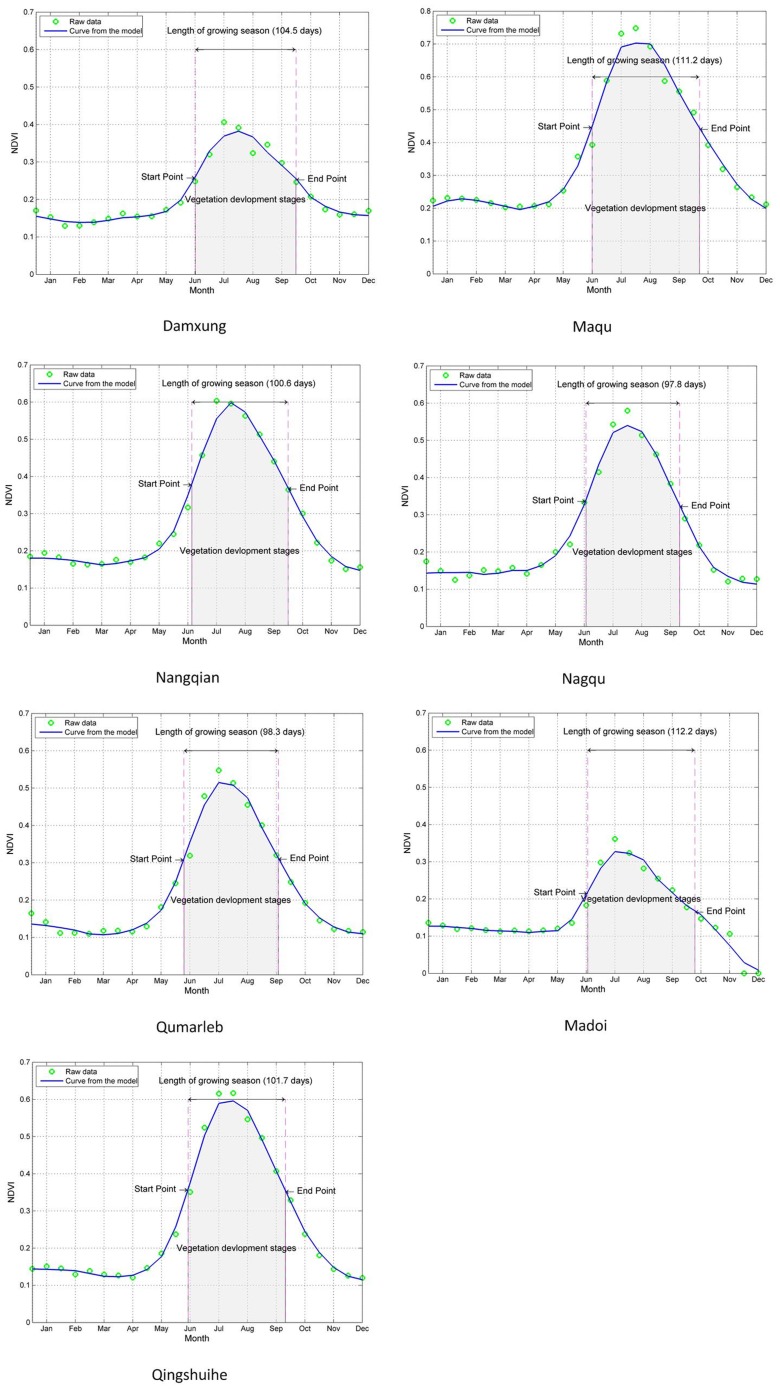
Growing season and related phenological measures for seven meteorological stations.The diagrams depict upper envelope Savitzky–Golay filtered data, with time in month steps. Dots represent original NDVI data. The thick solid lines show fitted functions of SG. The start point is defined as the date of the inflection point of the NDVI curve and end points as the date at which NDVI drops to the same level as the measured right minimum level. In between these dates, vegetation development stages are defined, covering the entire growing season (shaded area).